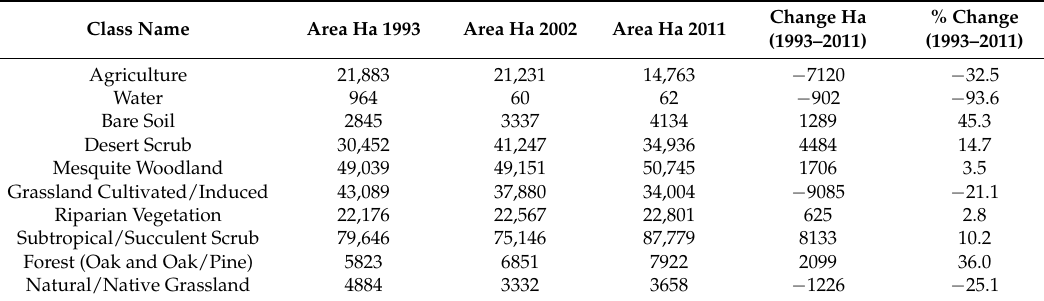
Table 5. Land cover trends for the 5 km buffer in the ZR and SMR